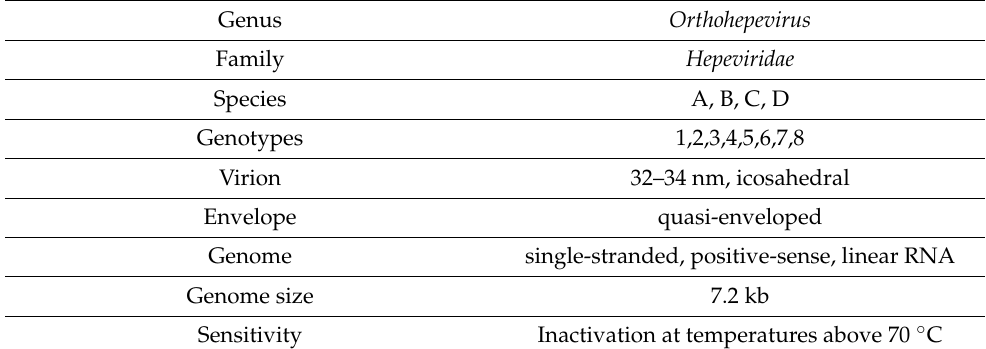
Table 1. Classification of hepatitis E virus (HEV).